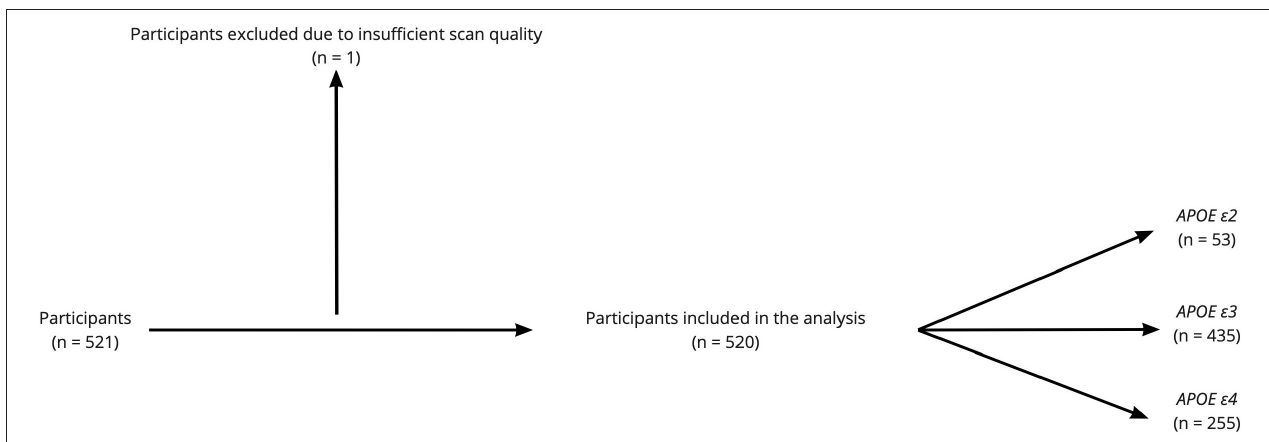
FIGURE 1 | Flow diagram of the participants enrolled in the study. Among the 520 participants included in the analysis, 399 participants had cerebrospinal fluid (CSF) analysis for routine Alzheimer’s disease (AD) biomarkers.